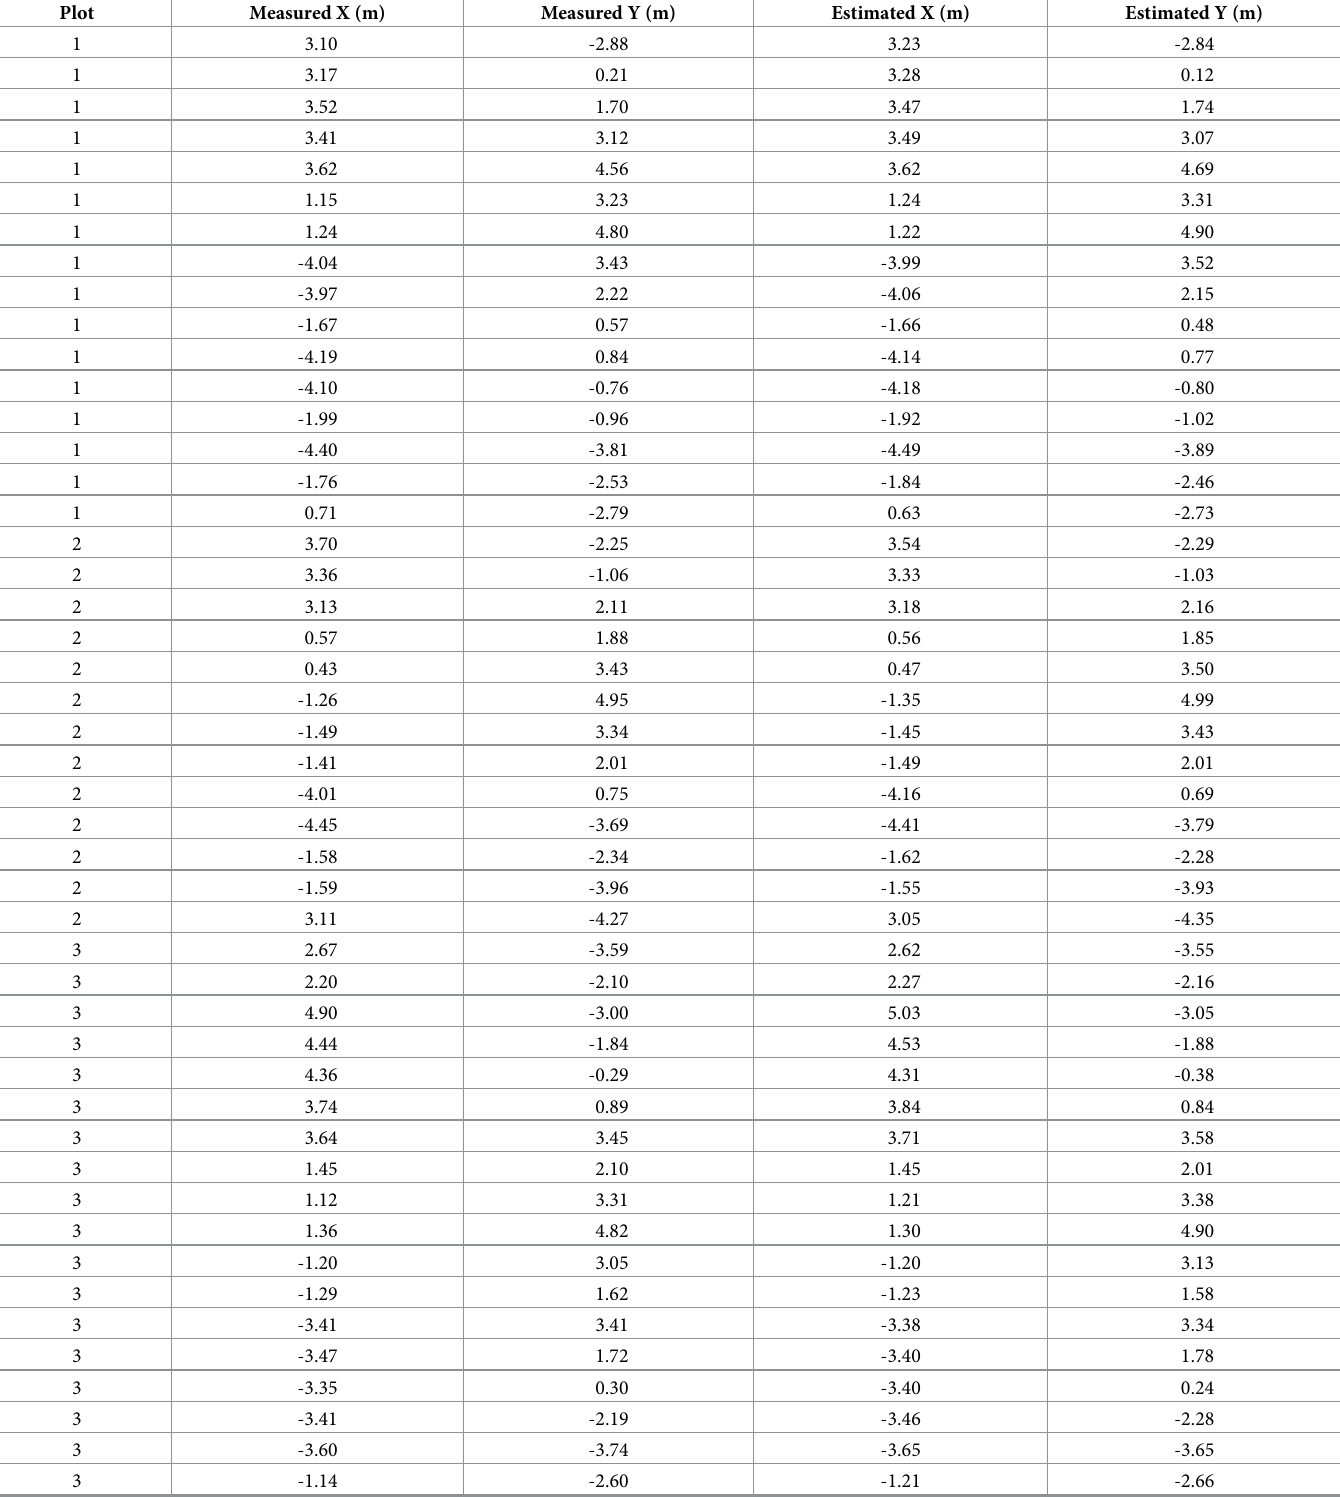
Table 5. The measured and estimated positions of trees.